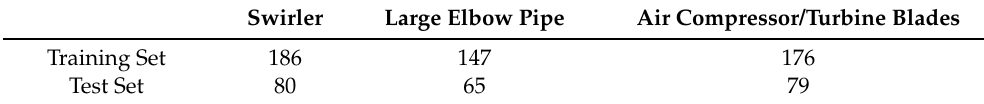
Table 4. Dataset division of swirler, large elbow pipe, and air compressor/turbine blades.